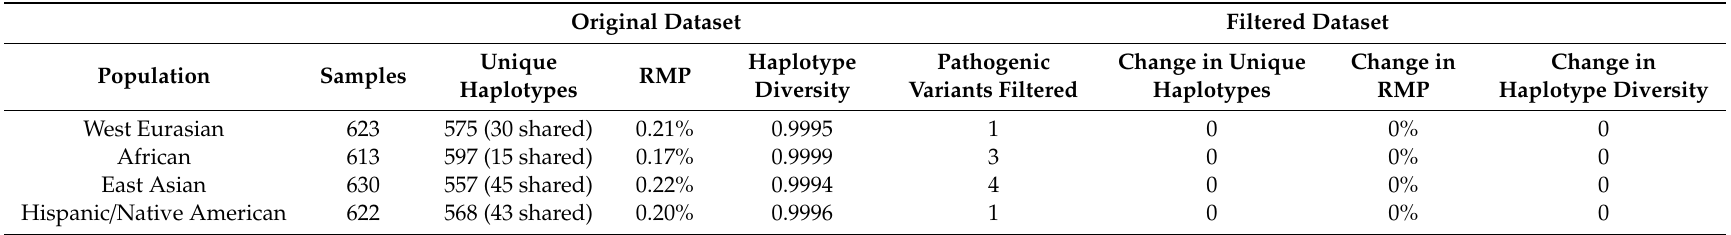
Table 3. The change in the number of unique haplotypes, observed random match probability (RMP), and haplotype diversity estimates when considering